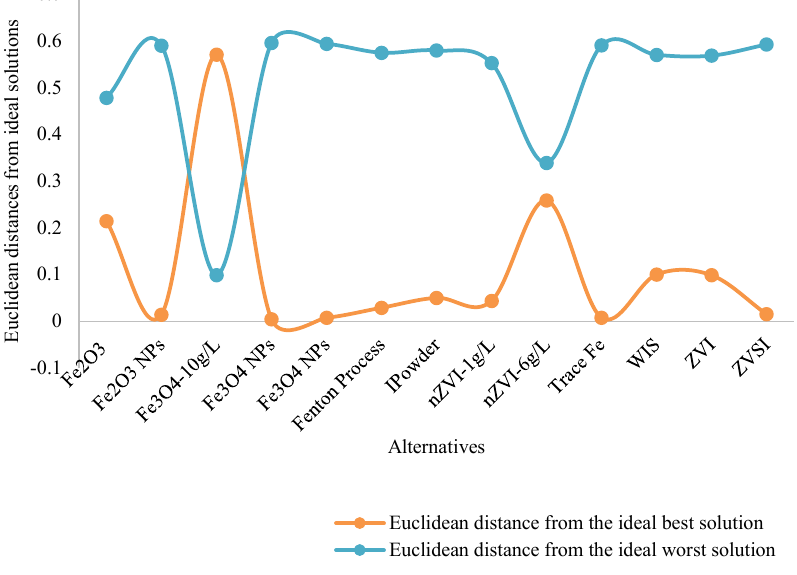
Fig. 2. Comparative plot of Euclidean distances from the ideal